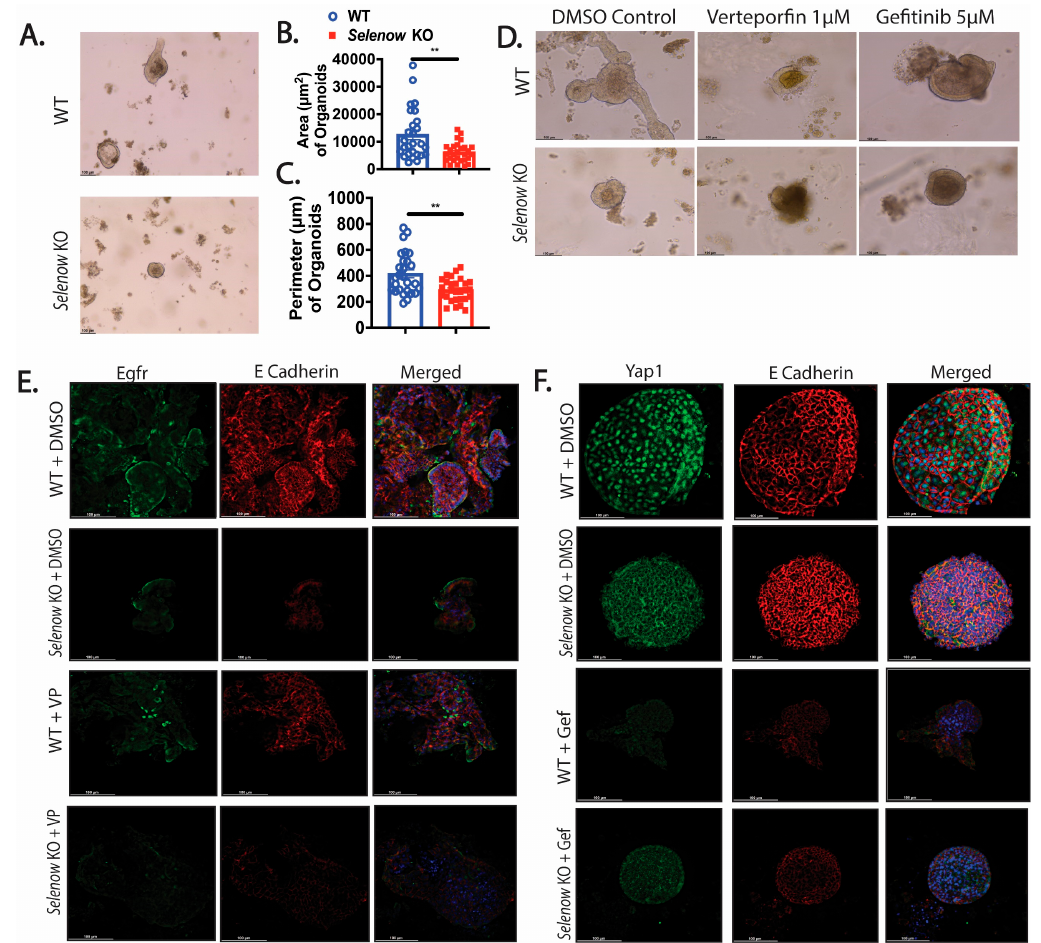
Figure 8. Inhibition of Yap1 and Egfr disrupts organoid morphology. ( A ) Representative image of WT and Selenow KO colonoids and ( B , C ) quantification of the area and perimeter of the WT and